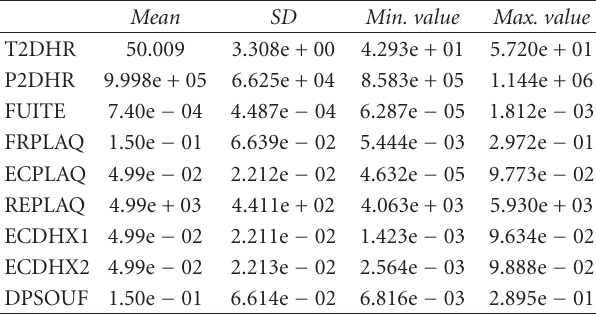
Table 2: Mean, standard deviation (SD), and upper and lower bounds for critical parameters after LHS (100